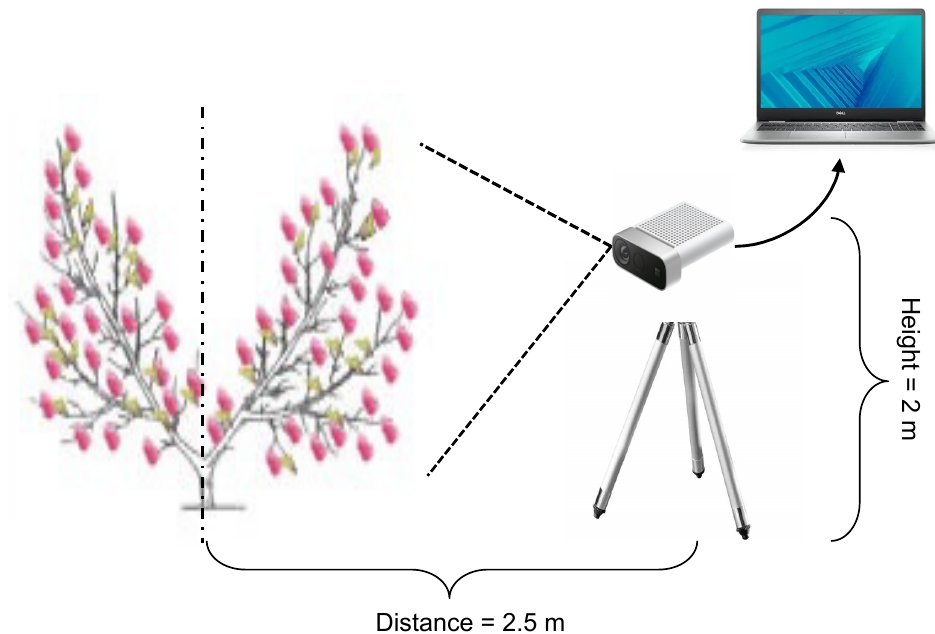
Figure 6. Schematic diagram of data acquisition system.